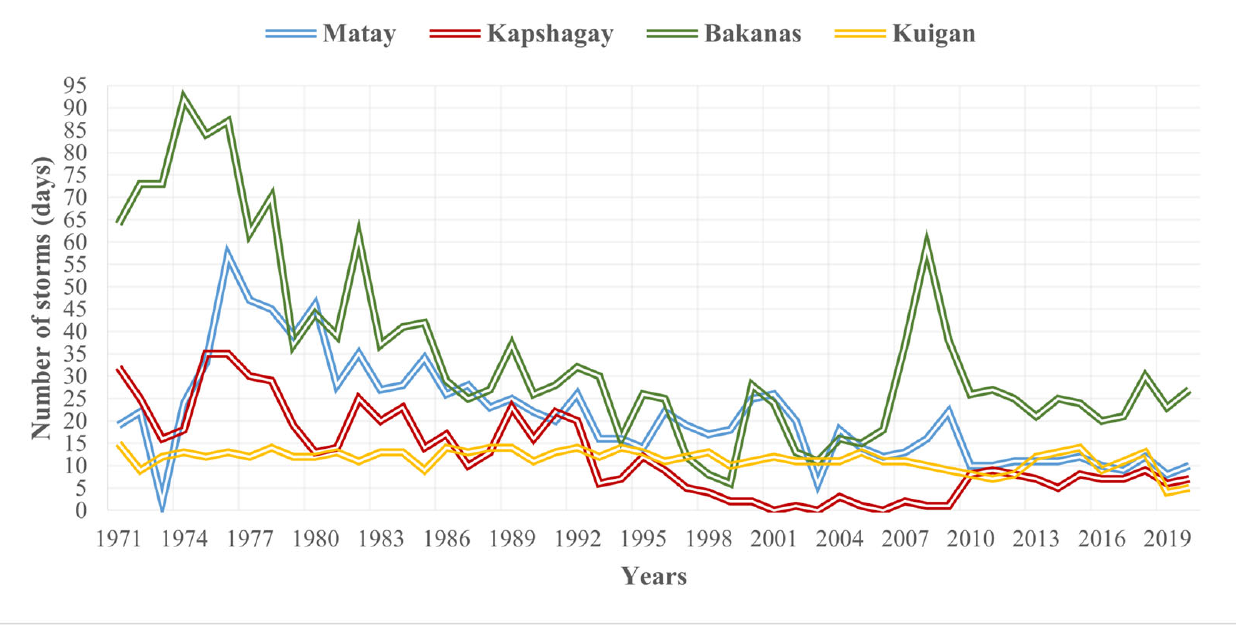
bility. For example, the spring and summer seasons are more favorable to storm out ‐ breaks. According to the data analysis of storms in the Southern Balkash deserts, two peaks were detected from 1966 to 2003: in April–June and July–September (Figure 4). Figure 4. Seasonal frequency of storms for the period 1966–2003 in the Southern Balkash deserts. Because of the sharp rise in temperature and high wind speed in the spring [59], the surface of southern deserts deteriorates in theintensive evaporation of humidity, which, together with strong winds, contributes to the development of dust and sand storm phe ‐ nomena. As a result, the southern deserts of the Balkash (meteorological stations: Bakanas, Kuigan, and Matay) are one of the main areas of Kazakhstan where regular storms occur, especially in the period from April to August and April–September (Figure 4). The aver ‐ age annual duration of storms for the period 1966–2003 was 43 days at the Bakanas mete ‐ orological station, 40 days at the Kuigan station, and 28 and 17 days per year at the Matay and Kapshagay stations , respectively.